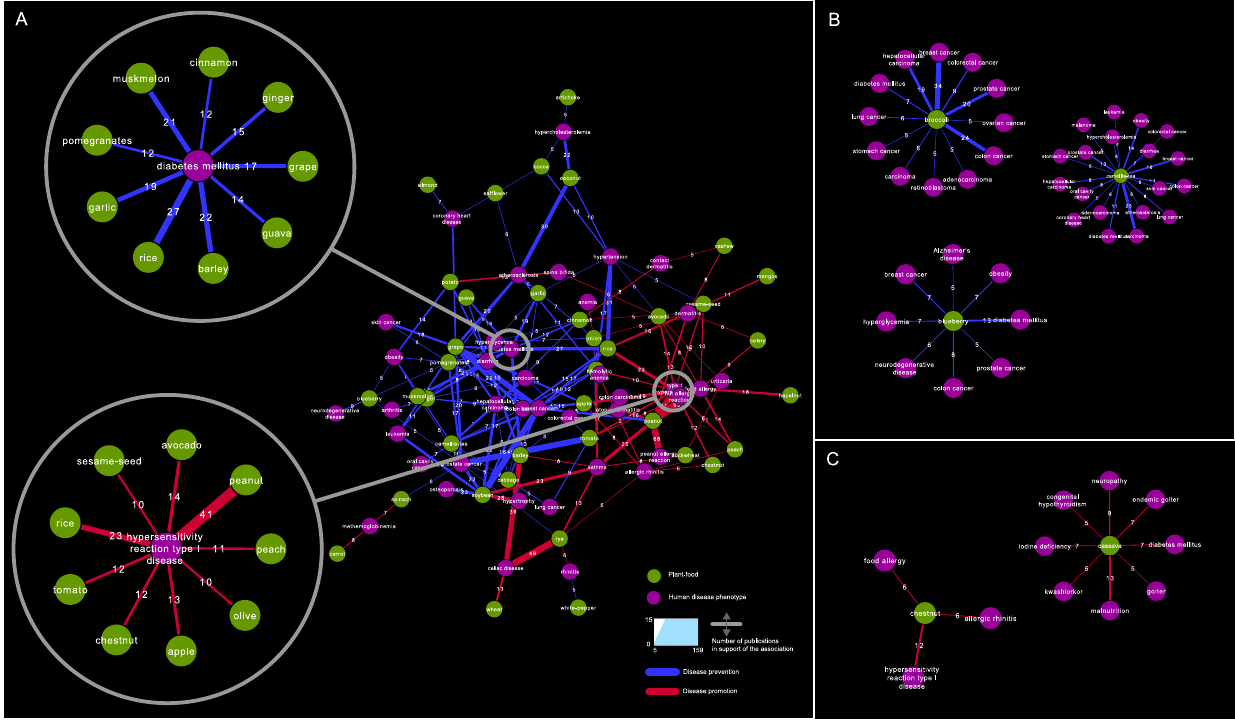
Figure 3. Food – disease association network. a) Disease phenotypes associated with common vegetables, fruits and plants of our diet. Foods are shown as green nodes and human disease phenotypes as purple nodes. Disease prevention/amelioration is depicted as a blue edge and disease promotion as a red edge. The size of the edge indicates the number of publications in support of the association. An edge is drawn between a food node and a disease node when there are at least five publications in support of this association. When a disease node has more than five edges, only the five strongest (with the most publication support) are shown on the network for the sake of clarity. Top left: zoom in the network formed between diabetes mellitus and foods that prevent/ameliorate the disease. Bottom left: zoom in the network formed between Type 1 hypersensitivity and foods that promote it. b) Examples of a vegetable (broccoli), a fruit (blueberry) and a plant-based beverage (camellia-tea) that are only positively associated with disease phenotypes. c) Two examples of foods that are only negatively associated with disease